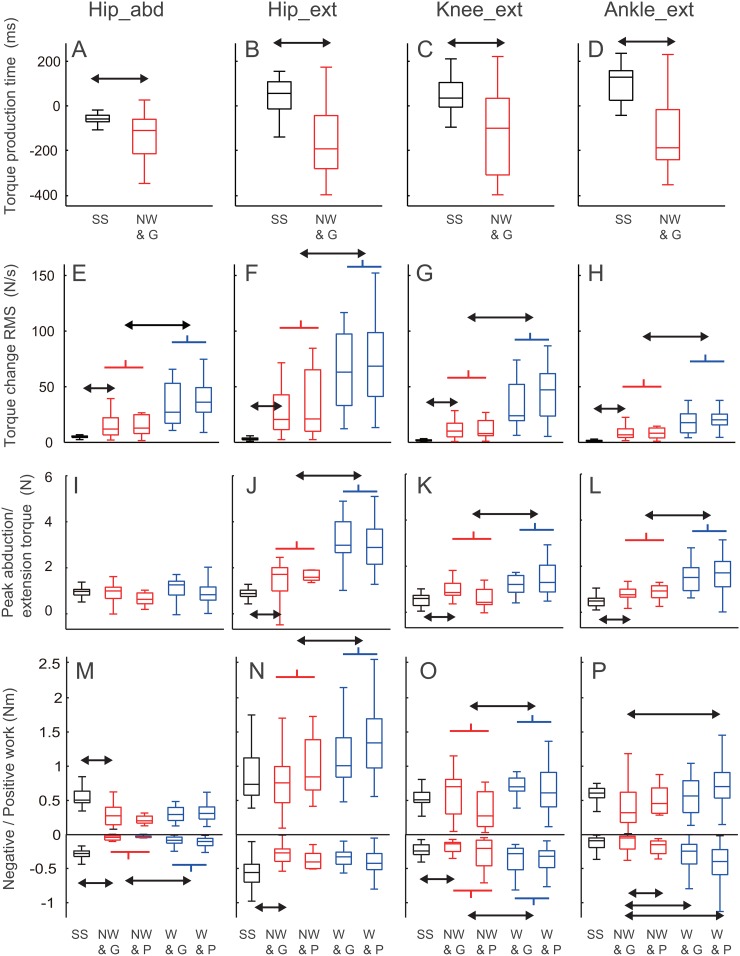
Joint torque parameters.Boxplots including median value and the 25th and 75th percentiles in initiation time of the joint torque (A-D), root mean squares of in time differential of joint torque (E-H), peak joint torques (I-L) and total positive and negative joint works (M-P) in choice-reaction sidestep (SS, black), non-weighted in guarding (NW & G, red) and penetrating trials (NW & P, red), and weighted in guarding (W & G, blue) and penetrating trials (W & P, blue). Horizontal arrows represent statistically significant differences between SS and NW & G or between NW and W. Initiation time of the joint torque was calculated only for comparisons of kinetic variables between sidestepping task and successful defense trial, whereas this analysis were not performed in the largely fluctuated trials such as in the weighted state (Fig 3).